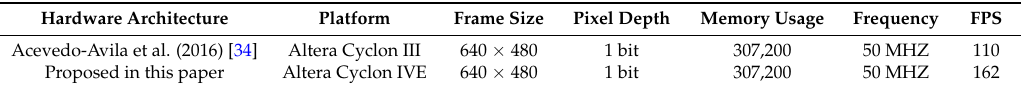
Table 4. Performance comparison of the implemented systems on FPGA.